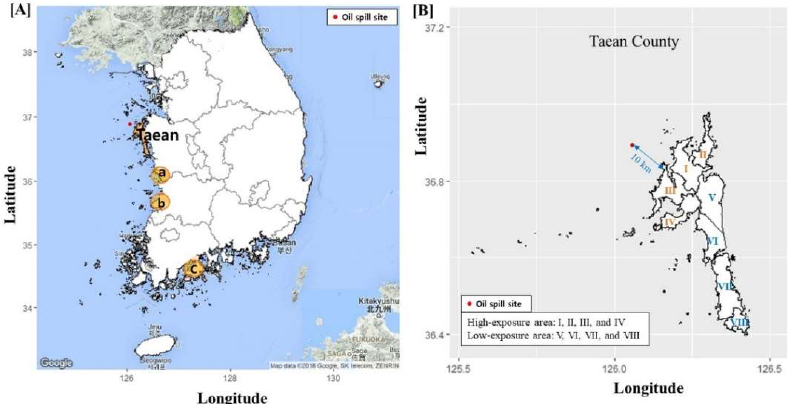
Figure 1. Map of Taean County and comparison of the coastal areas (a, b, and c) in Korea. ( A ) Comparison areas, “a”: Same province and same coastal area, “b”: Neighboring province and same coastal area, and “c”: Different province and different coast. The areas for comparison were selected based on their similarities to Taean County in terms of their characteristics and population size. ( B ) Taean